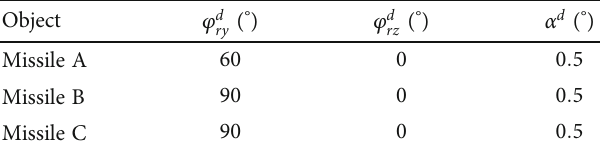
Table 2: Desired impact LOS angle and attack angle of missiles.